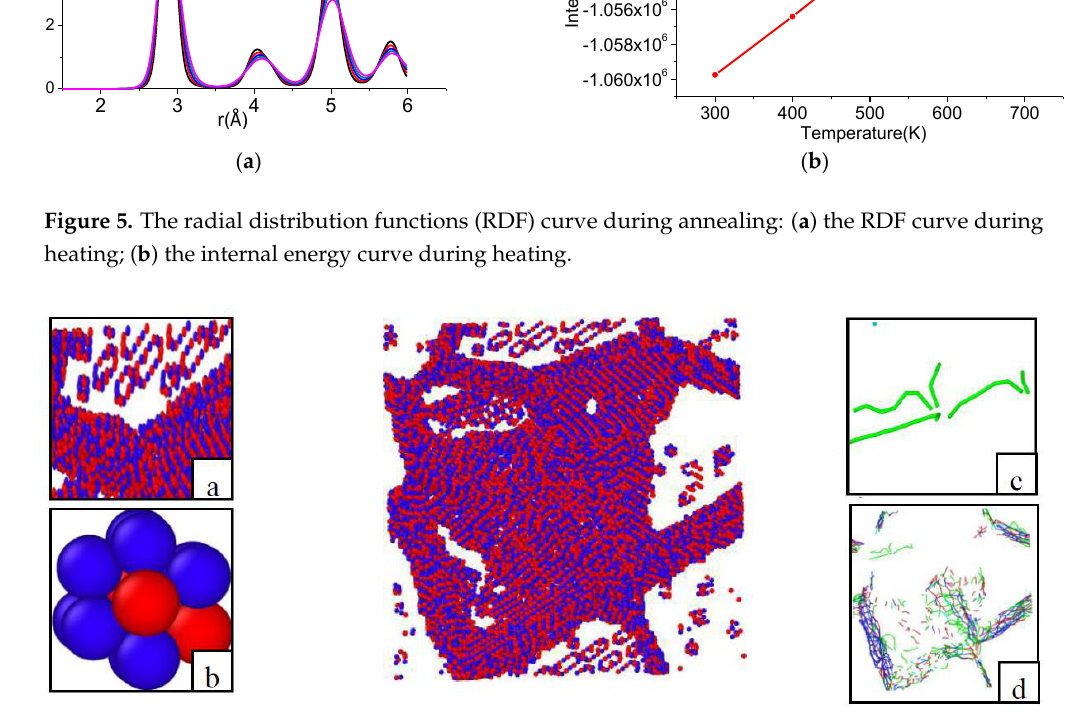
Figure 5. The radial distribution functions (RDF) curve during annealing: ( a ) the RDF curve during heating; ( b ) the internal energy curve during heating.